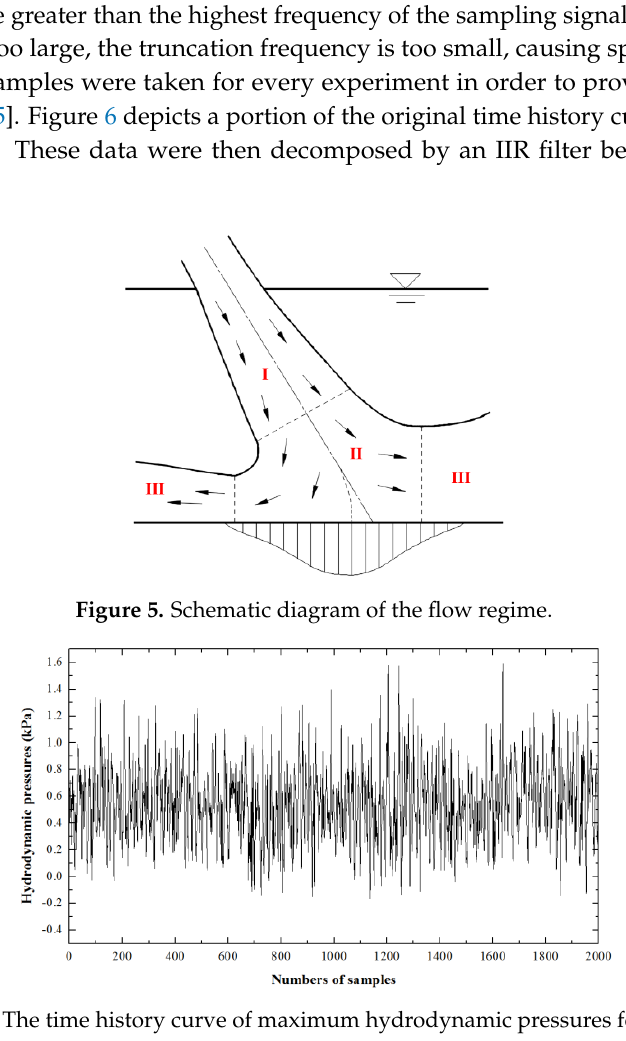
Figure 6. The time history curve of maximum hydrodynamic pressures for Case 3.